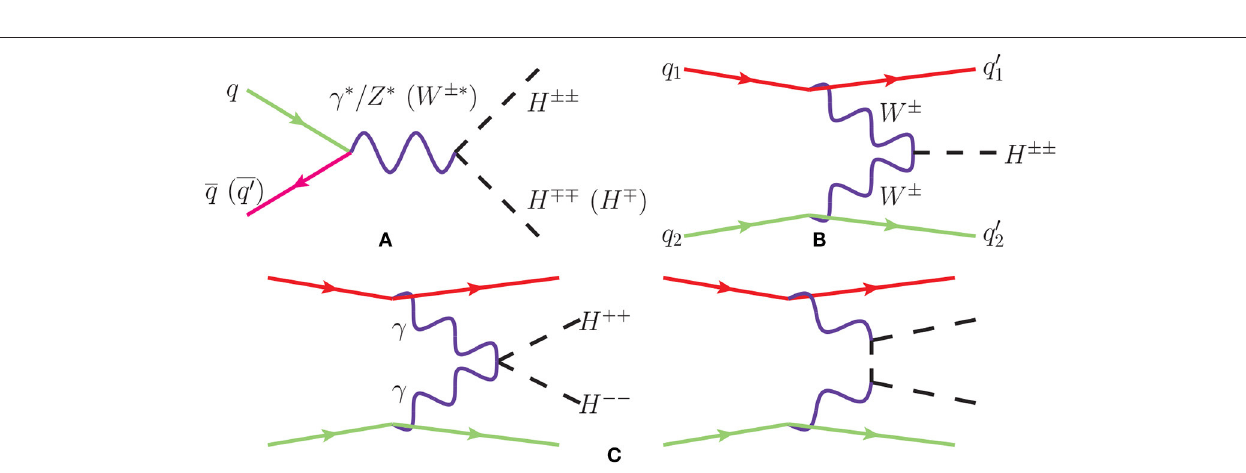
FIGURE 27 | Scatter plots of the same (A) and different (B) flavor leptonic branching fractions for the H ++ decay vs. the Majorana phase 8 1 for the IH with m 3 and 8 2 (0,2 π ). ∈